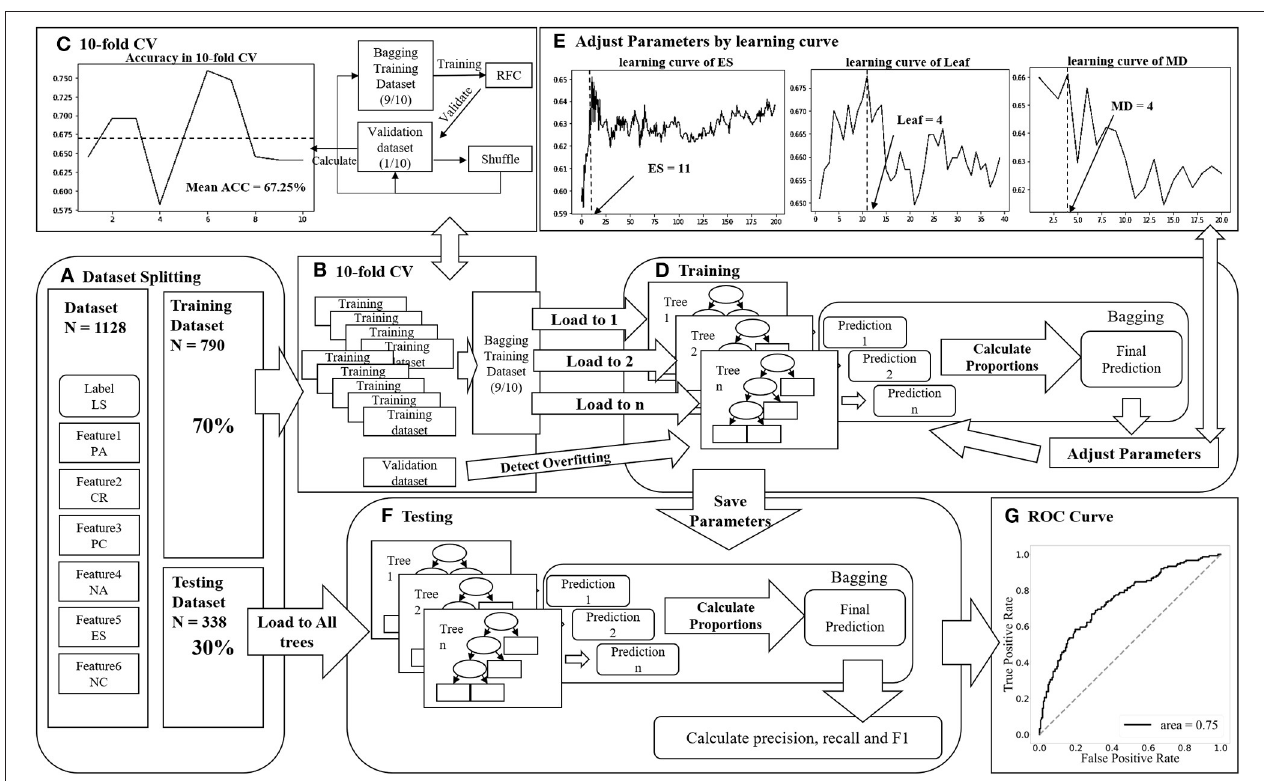
FIGURE 2 | (A) Dataset was divided into a training dataset (70%) and a testing dataset (30%). PC, positive coping; NC, negative coping; CR, cognitive reappraisal; ES, expression suppression; PA, positive affect; NA, negative affect; LS, life satisfaction; RFC, random forest classification; ROC, receiver operating characteristic. (B) Training datasets were divided into 10 folds, one used to validate the model and the rest bagging to train a RFC model. (C) Tenfold cross-validation was reused 10 times to calculate the mean accuracy, and each time we randomly reshuffled our training folds and validation fold. (D) Many different decision trees were trained in RFC model by adjusting parameters to find the optimal fitting by training dataset and detect whether there was overfitting by validation dataset. (E) Learning curves were used to detect the optimal pairs of parameters. The accuracy of the model was calculated by the remaining other parameters and changing one parameter. After calculating all accuracies, we choose the value that presents the enormous accuracy. (F) After training, we use the testing dataset to calculate the trained RFC model’s final index. (G) The ROC curve of RFC model shows the performance of this model.